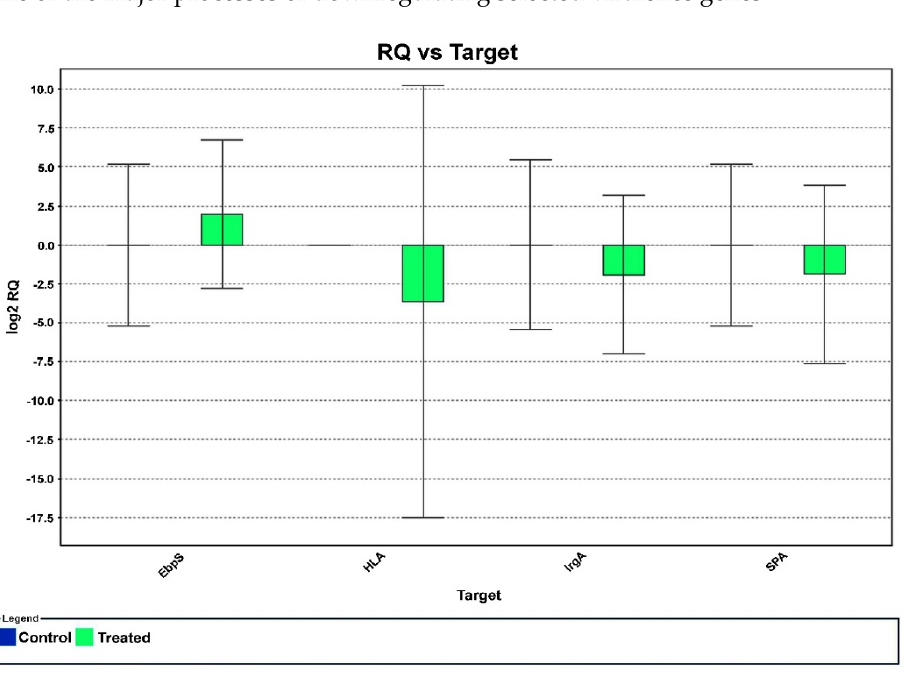
Figure 5. The effect of HPAEtOAc crude extract on selected MRSA gene expression in real − time PCR. The negative values denote the downregulation of targeted genes at 150 µg/mL of HPAEtOAc crude extract.